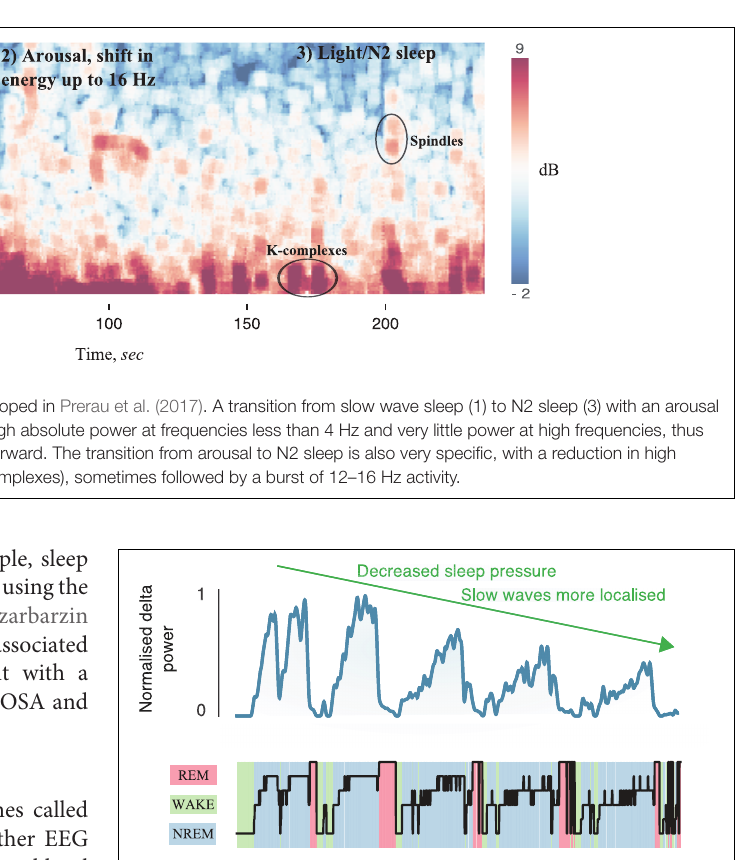
FIGURE 4 | Cyclical variation in delta power across the